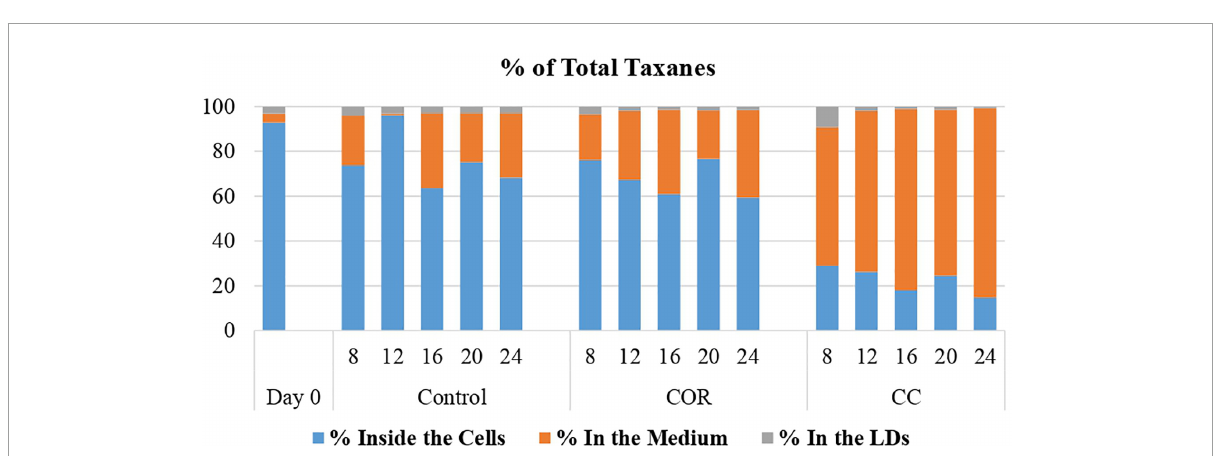
FIGURE5 Percentage of the total taxanes found inside the cell, liquid medium and lipid droplets (LDs). T. baccata cell cultures were maintained for 24 days in control conditions, or with the addition of coronatine (Cor) or Cor + β -cyclodextrins (CC). Values presented are means ± SD ( n = 3). Values followed by different letters are significantly different ( P ≤ 0.05) according to Tukey’s honestly significant difference